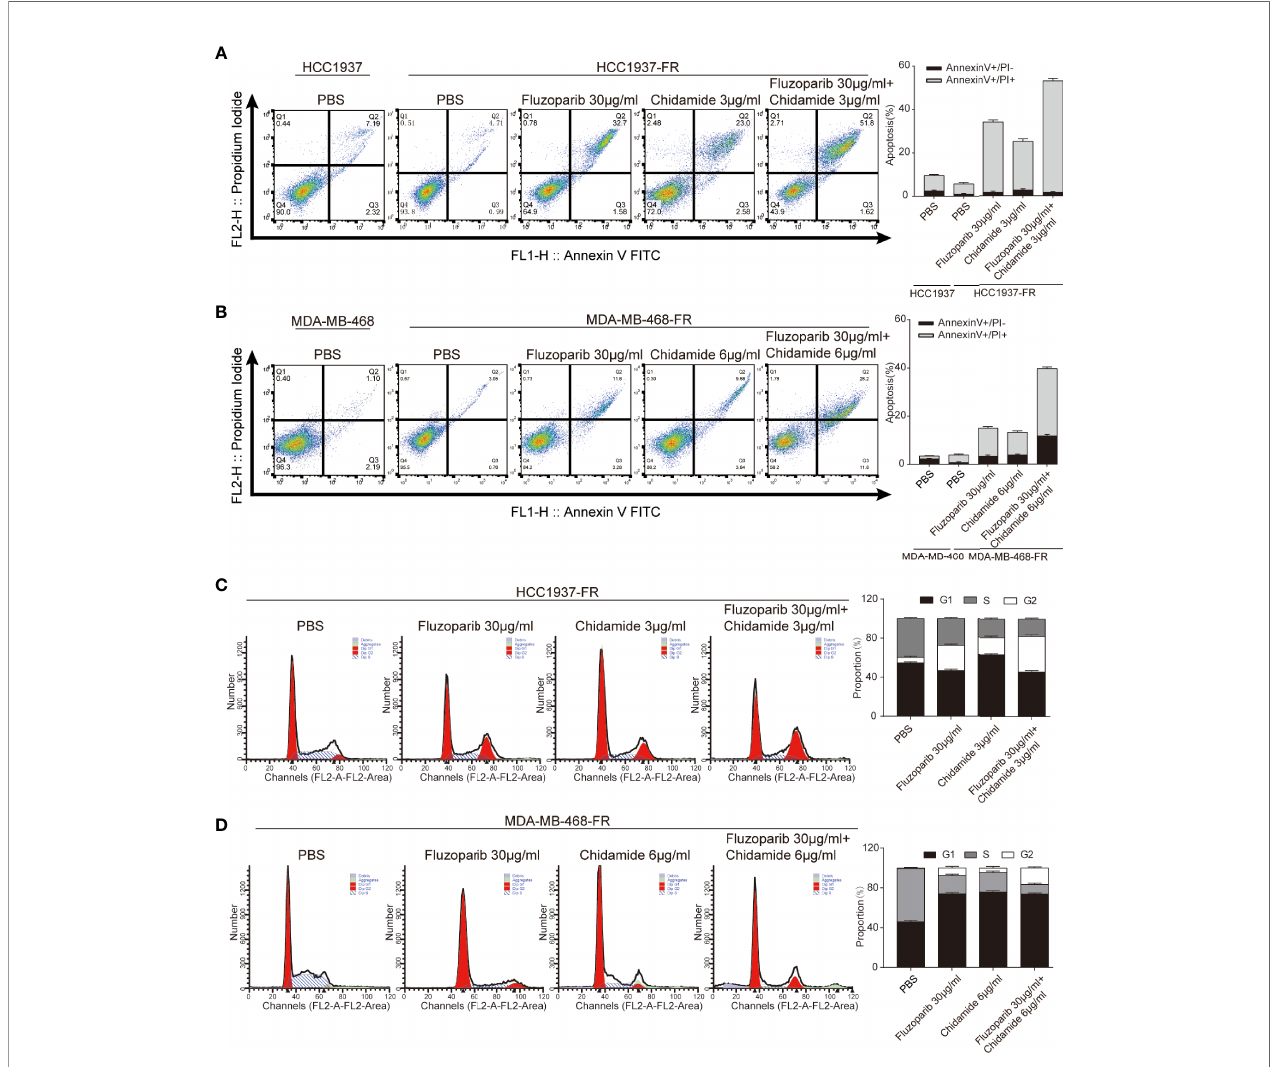
FIGURE 3 | Effects of chidamide and fl uzoparib on cell cycle and apoptosis. (A, B) Cell apoptosis was detected using Annexin V-FITC/PI double staining followed by fl ow cytometry for parental and fl uzoparib-resistant HCC1937 and MDA-MB-468 cells after incubation with PBS, fl uzoparib, chidamide, or a combination treatment ( fl uzoparib + chidamide) for 24 h. (C, D) Cell cycle analysis using PI staining and following fl ow cytometry for HCC1937-FR and MDA-MB-468-FR cells after incubation with PBS, fl uzoparib, chidamide, or a combination treatment ( fl uzoparib + chidamide) for 24 h. Data represent the mean ± SD of three independent